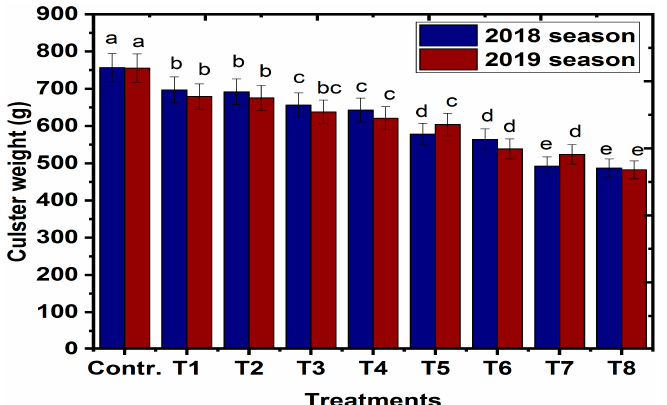
Figure 4. Effect of hand thinning and GA 3 spray sizing on cluster weight during 2018 and 2019 seasons. Contr.: without removing any shoulders of the cluster, T1: 25% hand thinning + 20 ppm GA 3 sizing, T2: 25% hand thinning + 30 ppm GA 3 sizing, T3: 25% hand thinning + 40 ppm GA 3 sizing, T4: 25% hand thinning without GA3 sizing, T5: 50% hand thinning + 20 ppm GA 3 sizing, T6: 50% hand thinning + 30 ppm GA 3 sizing, T7: 50% hand thinning + 40 ppm GA3 sizing and T8: 50% hand thinning without GA 3 sizing. Means in each column followed by the same letter (s) are not significantly different at ( p ≤ 0.05), using Duncan’s Multiple Range